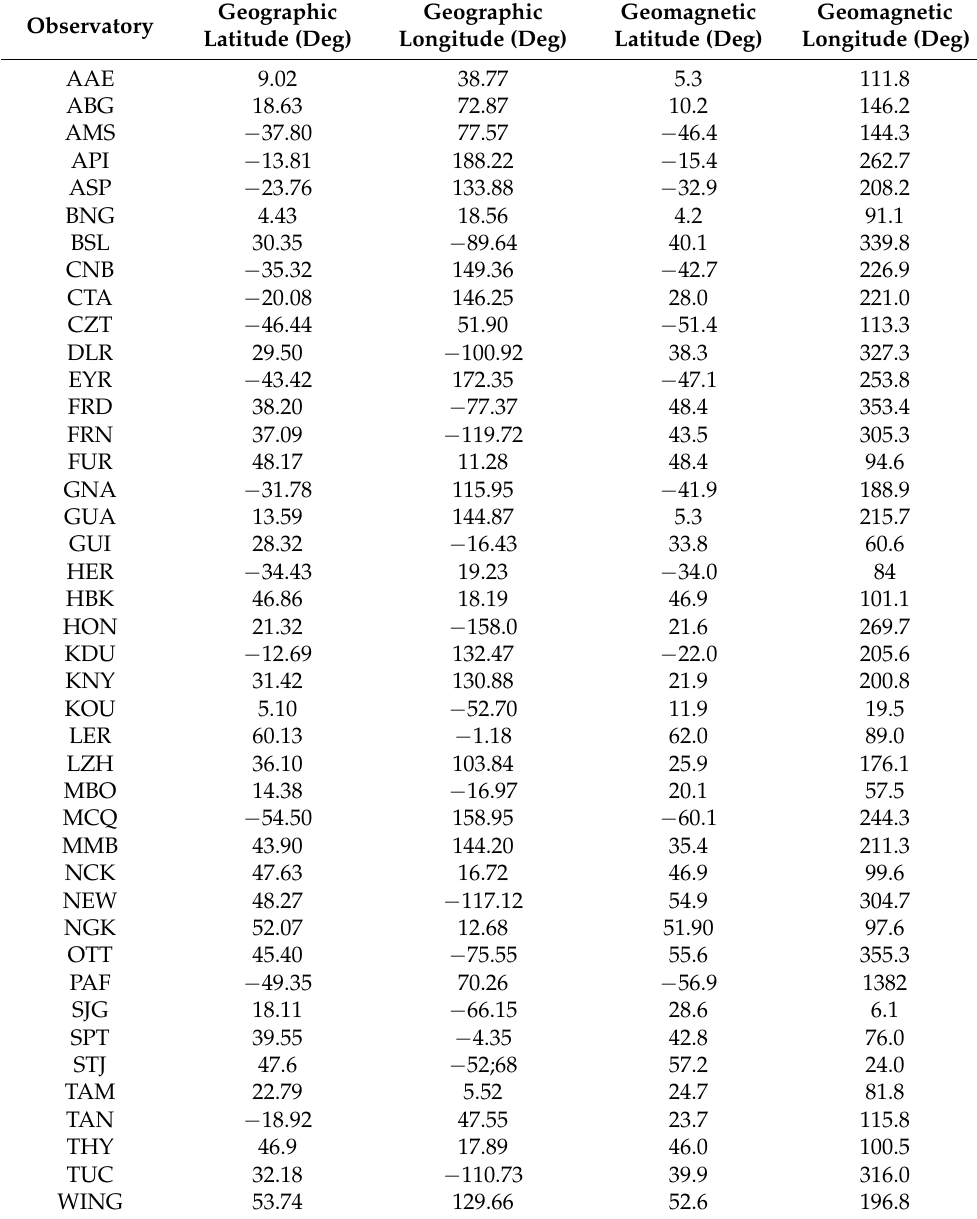
Table 1. Geographic and geomagnetic coordinates of magnetic observatories participating in INTER-